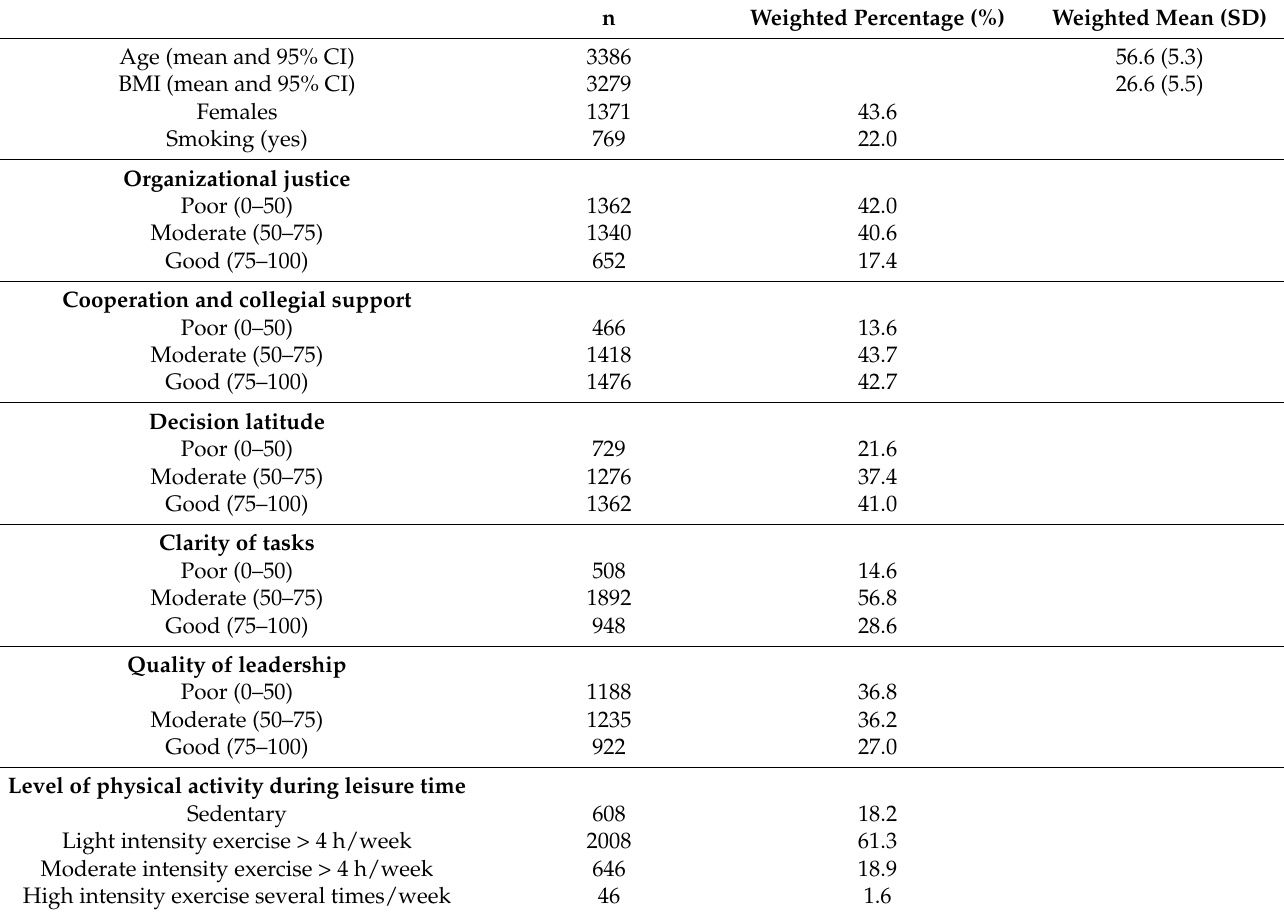
Table 1. Demographics and weighted prevalence of work-related psychosocial